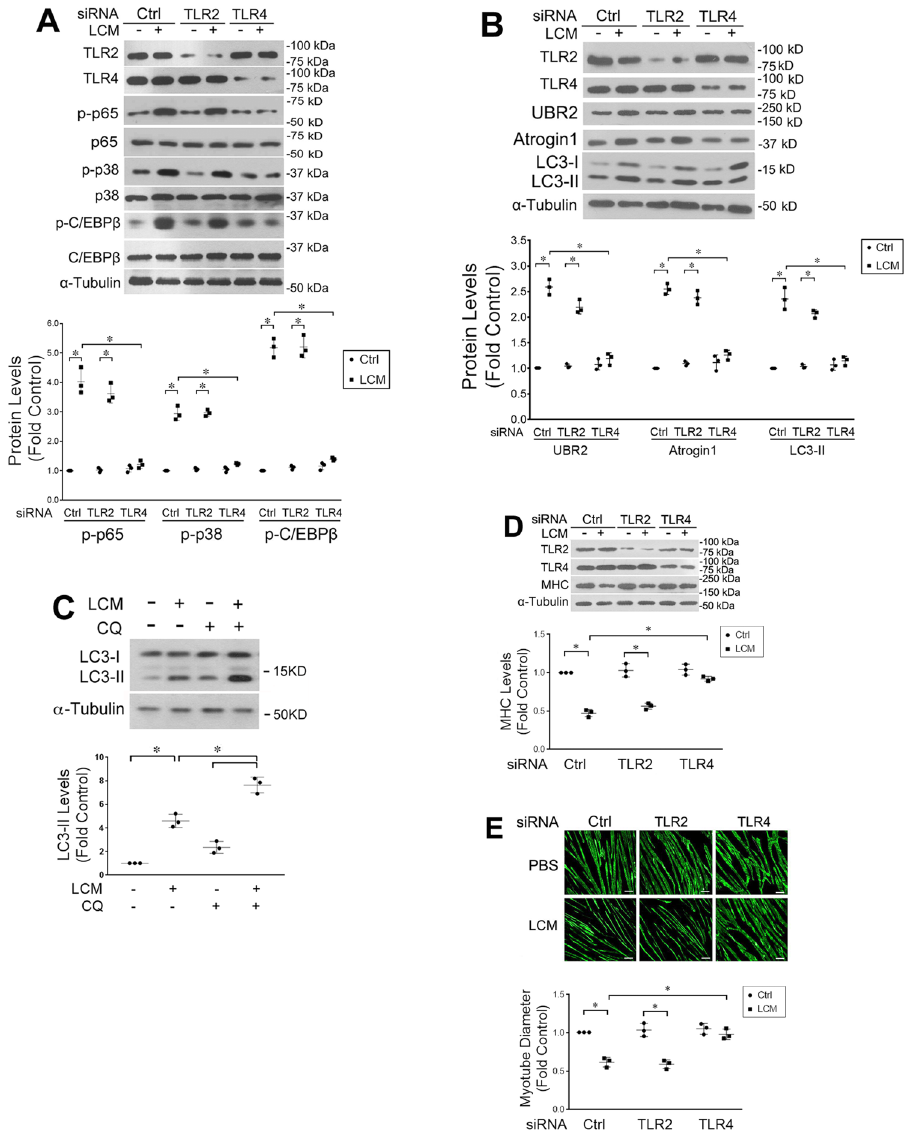
Figure 1. LLC cell-conditioned medium activates myotube catabolism through TLR4. C2C12 myoblasts were transfected with indicated siRNAs. After incubation in differentiation medium for 96 h, myotubes were treated with Lewis lung carcinoma cell-conditioned medium (LCM) or control medium. Activation of NF- κ B (p65), p38 MAPK and C/EBP β was evaluated by Western blot analysis of cell lysate in 1 h ( A ). Levels of UBR2, atrogin1 and LC3-II were evaluated by Western blot analysis of cell lysate in 8 h ( B ). Autophagy flux increase was demonstrated by measuring LC3-II levels in myotubes pre-treated with 20 μ M of lysosome inhibitor chloroquine (CQ, C ). Levels of myosin heave chain (MHC) were evaluated by Western blot analysis of cell lysate in 72 h ( D ). TLR2 and TLR4 knockdown was monitored at each of the time points. Myotubes treated for 72 h were immunofluorescence-stained for MHC and their diameter was measured ( E ). Data was analyzed by ANOVA. * Denotes a difference ( P <